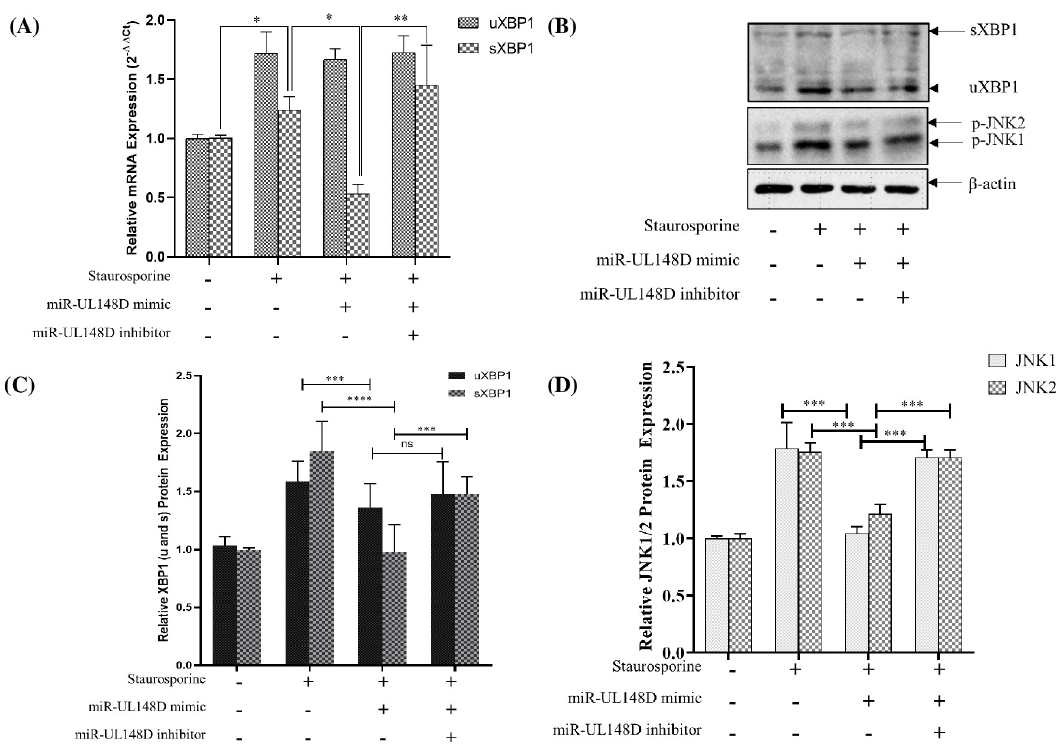
Fig 5. Hcmv-miR-UL148D regulates XBP1 splicing and JNK phosphorylation: (A) HEK293T cells were transfected with hcmv- miR-UL148D mimic or inhibitor followed by staurosporine treatment. RNA was isolated and XBP1 mRNA spliced (sXBP1) and unspliced (uXBP1) were measured through qRT-PCR. The uXBP1 and sXBP1 expression level were normalized to that of GAPDH and fold change was calculated and plotted with respect to the untreated control. Results represent the mean ± SEM (n = 3 independent experiments) � , p < 0.05, �� , p < 0.01. (B, C & D) Whole cell lysate was prepared from the hcmv-miR-UL148D mimic or inhibitor transfection and staurosporine treated cells. The expression of p-JNK, uXBP1 and sXBP1 were analyzed in different groups of cells through western blot and β -actin was used as a loading control. The bands of the blots have been cropped with no further manipulation. The Relative protein expression levels in different groups of cells were analyzed through ImageJ software. Results represent the mean ± SEM (n = 3 independent experiments) �� , p < 0.01; ��� , p < 0.001; ���� P < 0.0001; ns = non-significant.